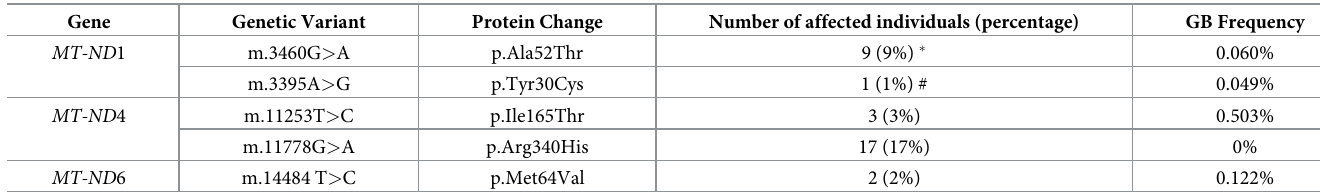
Table 1. Disease-causing variants identified in the Argentinean cohort. Gene Genetic Variant Protein Change Number of affected individuals (percentage) GB Frequency MT-ND